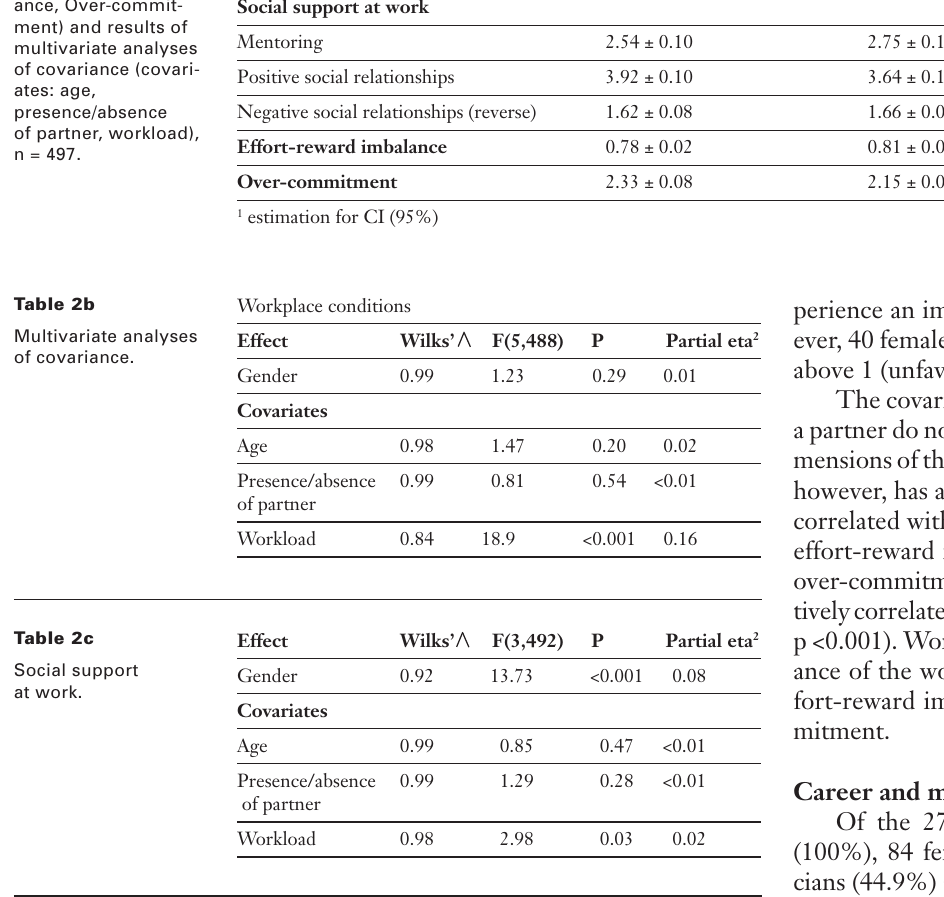
Effort-reward imbalance.